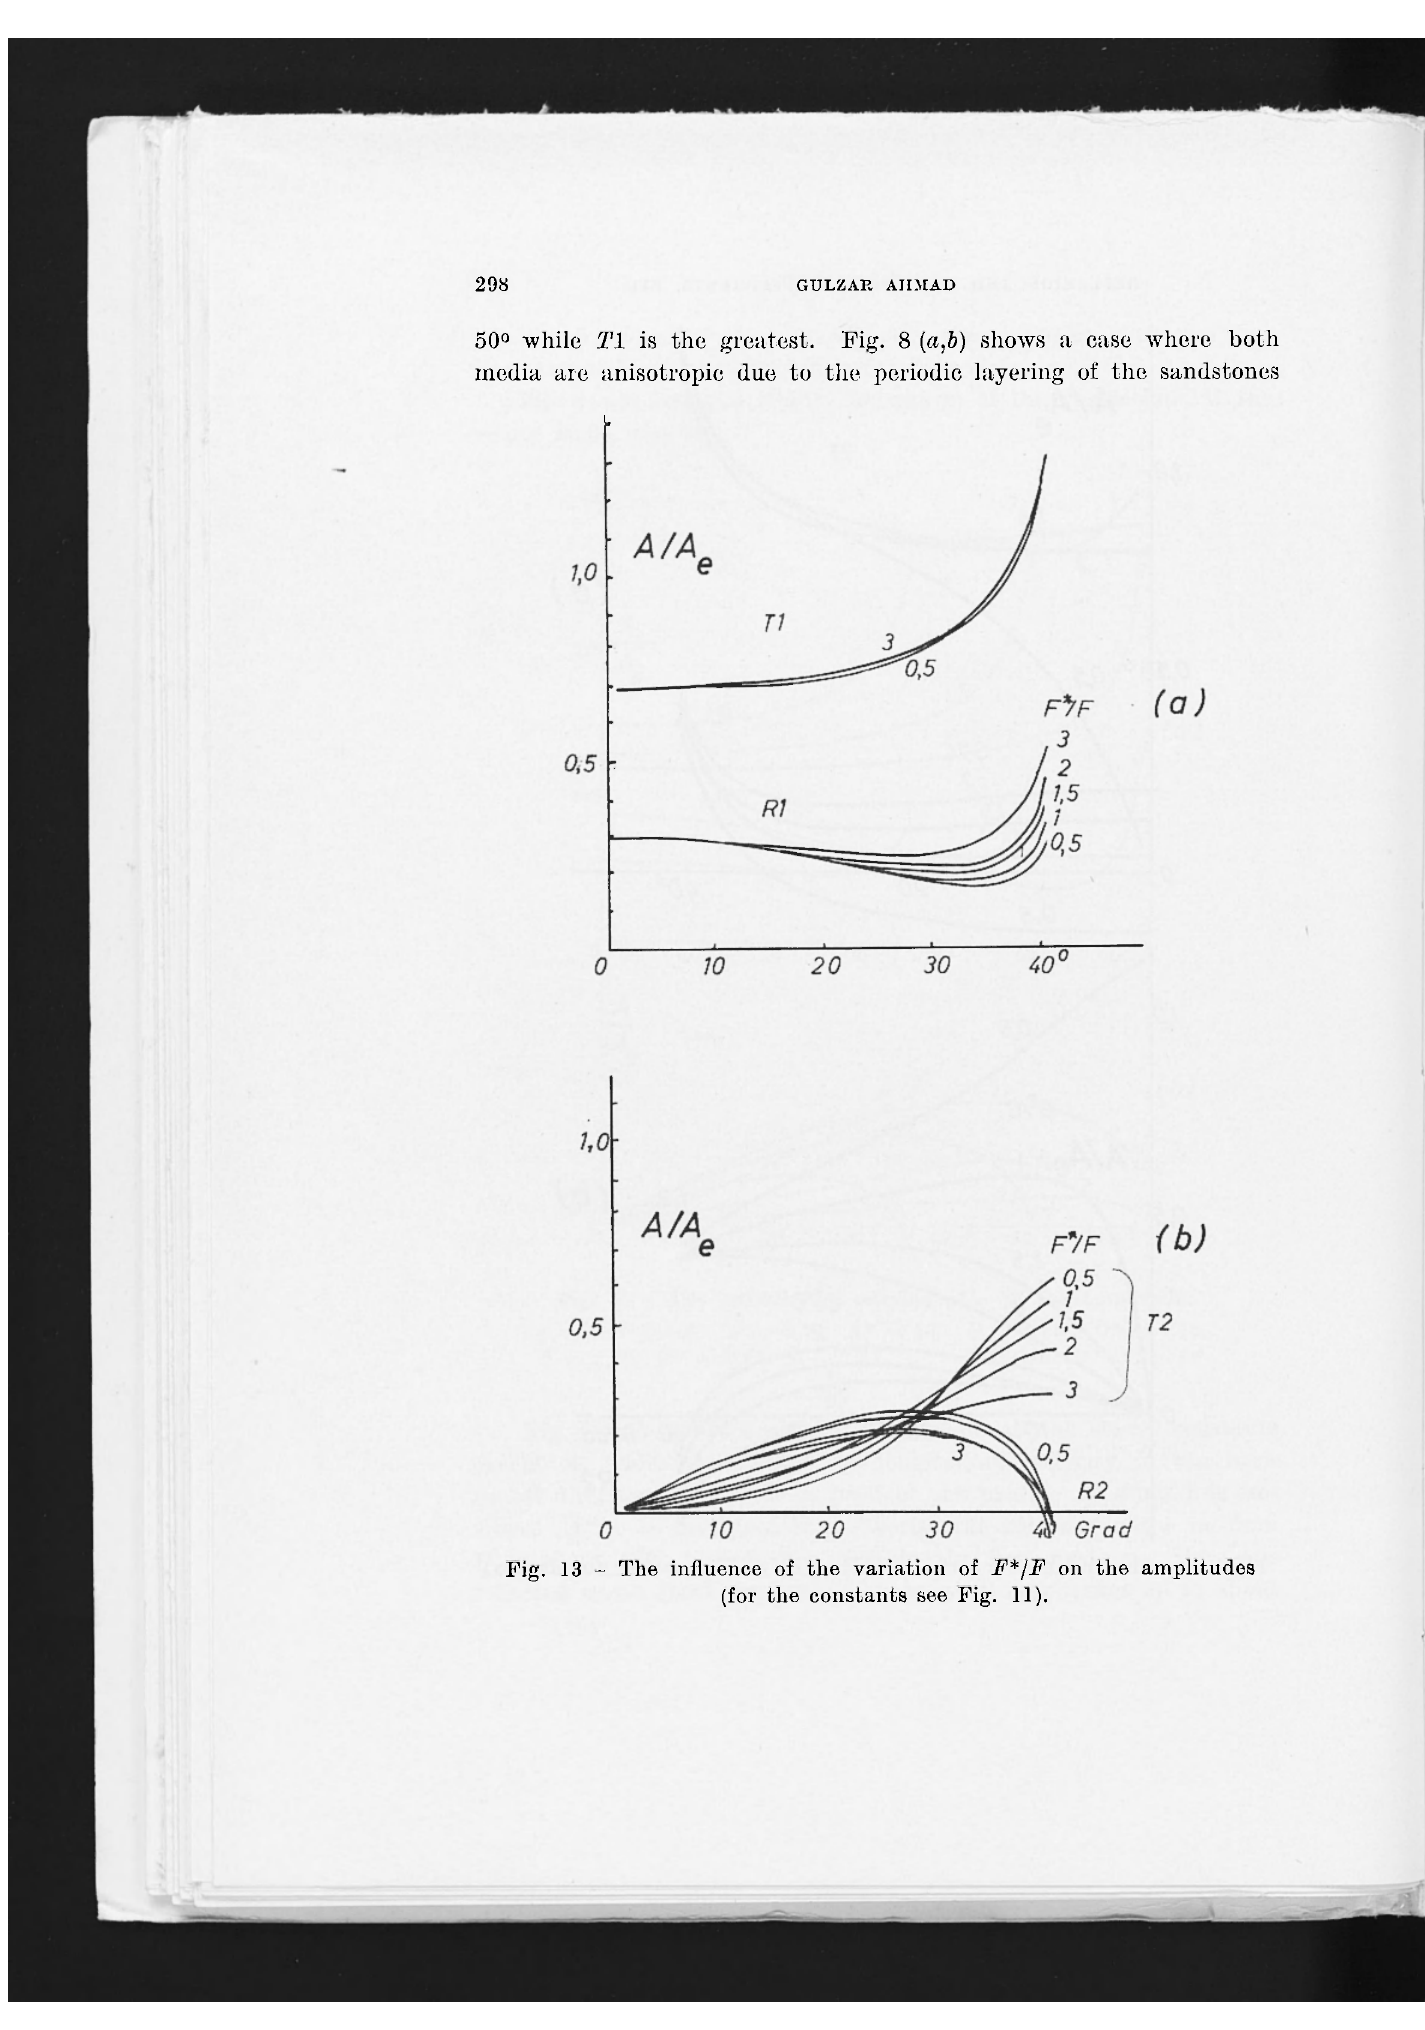
Fig. 13 - The influence of the variation of F*/F on the amplitudes (for the constants see Fig.